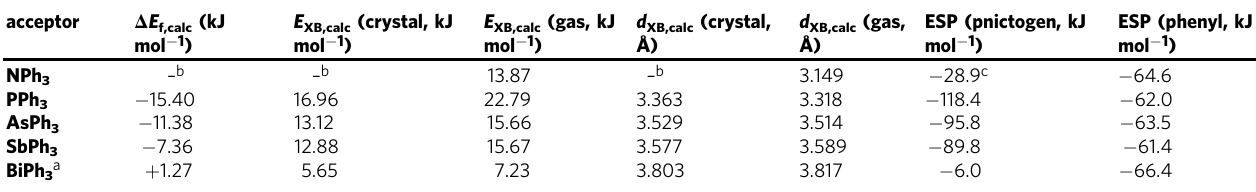
a Putative structure for ( tftib )( BiPh 3 ) cocrystal was generated from that of ( tftib )( SbPh 3 ) by replacing the Sb atom with Bi and optimization b Different geometry of NPh 3 compared to its congeners prevented generating a structure for the putative ( tftib )( NPh 3 ) cocrystal c Value corresponds to the point in the center of the molecule closest to the N atom